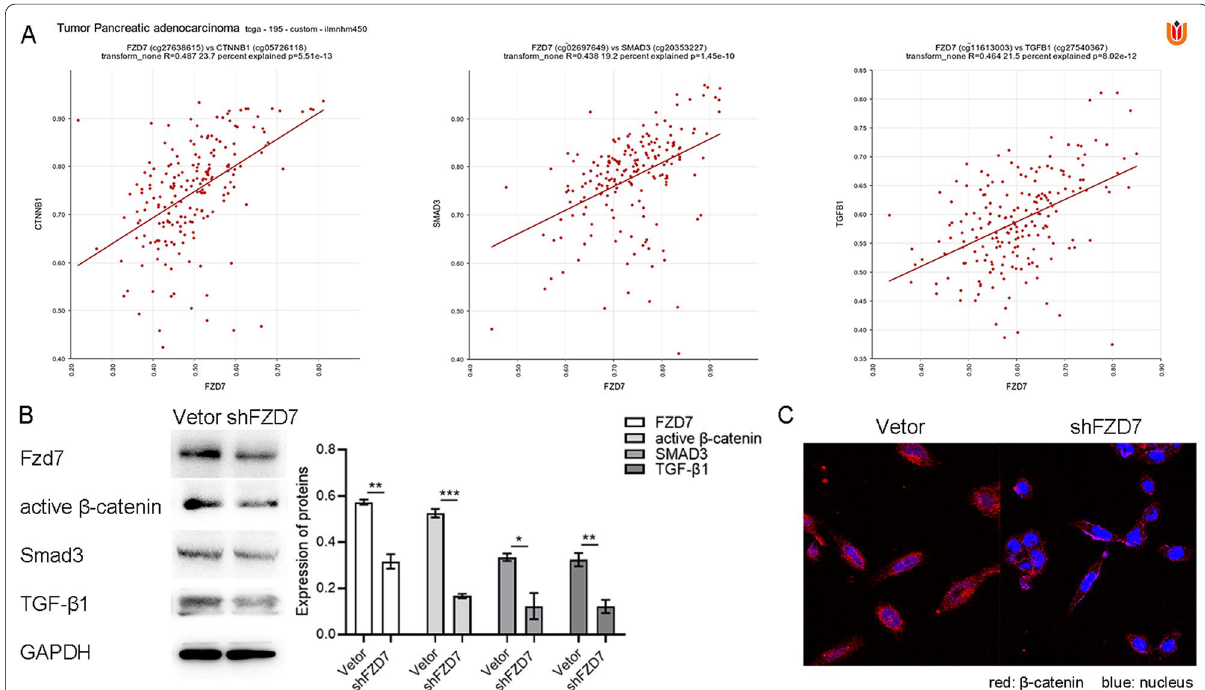
Fig. 5 FZD7 was positively correlated with the expressions of CTNNB1, SMAD3 and TGF-β1 at the gene level, with Pearson co-efficient values of 0.487 ( P 5.51e − 13 ), 0.438 ( P 1.45e − 10 ), and 0.464 ( P 8.02e − 12 ) respectively ( A ). Western blotting assay confirmed that the level of active = = = β-catenin, SMAD3 and TGF-β1 was decreased after FZD7 silenced ( B ). The reduction of active β-catenin after FZD7 silenced inside and outside of the nucleus was detected using immunofluorescence ( C ). Significant, * P < 0.05, ** P < 0.01, *** P < 0.001, Student’s